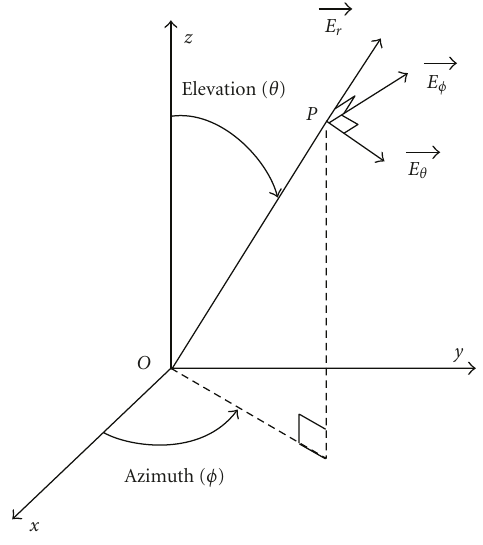
Figure 1: Reference system for ray